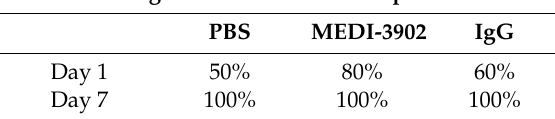
Table 1. MEDI3902 is not cytotoxic to the cornea and does not impede restoration of the corneal epithelial layer: One cornea for each mouse was disrupted using the corneal scratch method and then mice were given drops, either PBS, IgG, or MEDI3902, for one week. After one week, all mice had intact epithelium, demonstrating that the drops were not toxic to the corneal surface at experimental